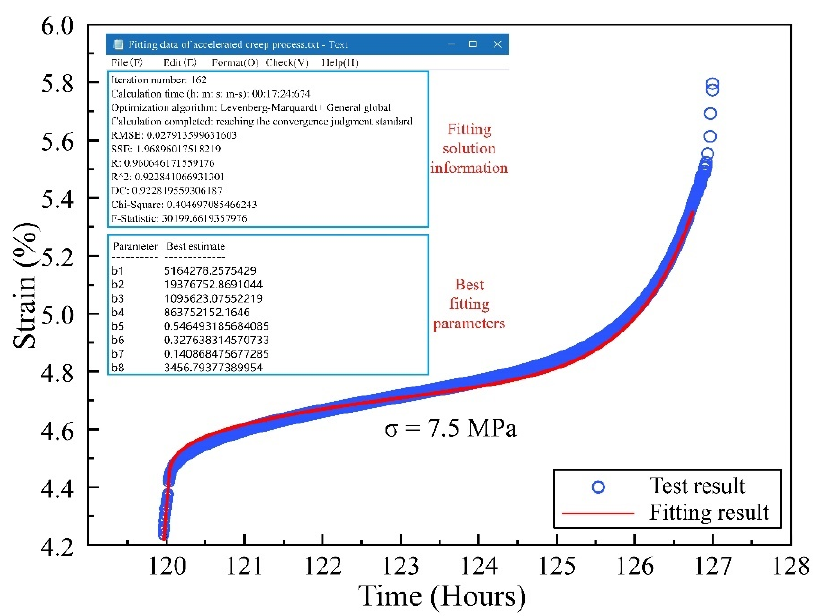
Figure 12. Fitting results of accelerated creep process.